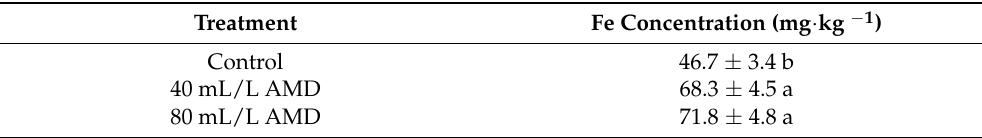
Table 2. Fe concentration in soybean seedlings in AMD after 7 days. (Different letters, a, and b, represent statistical differences between treatments; the error represents standard deviation; Fisher LSD multiple comparison; p < 0.05 level; N =